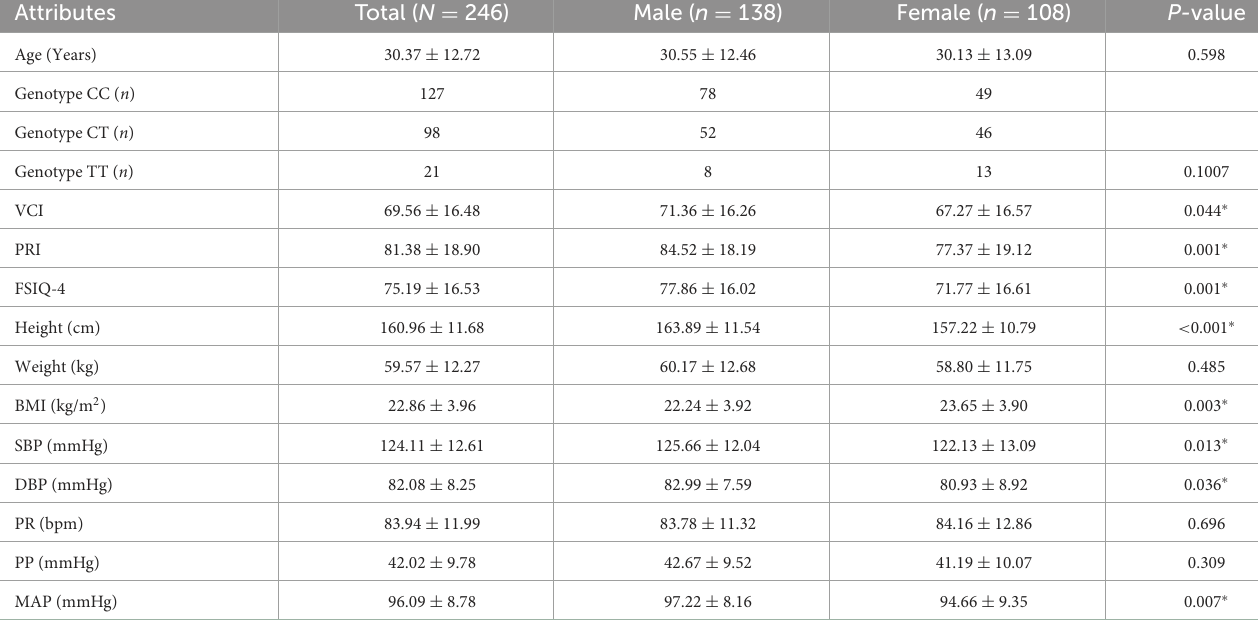
TABLE 1 Characteristics of studied participants ( N = 246) in terms of demographic, psychometric, morphometric, and physiometric data. Attributes